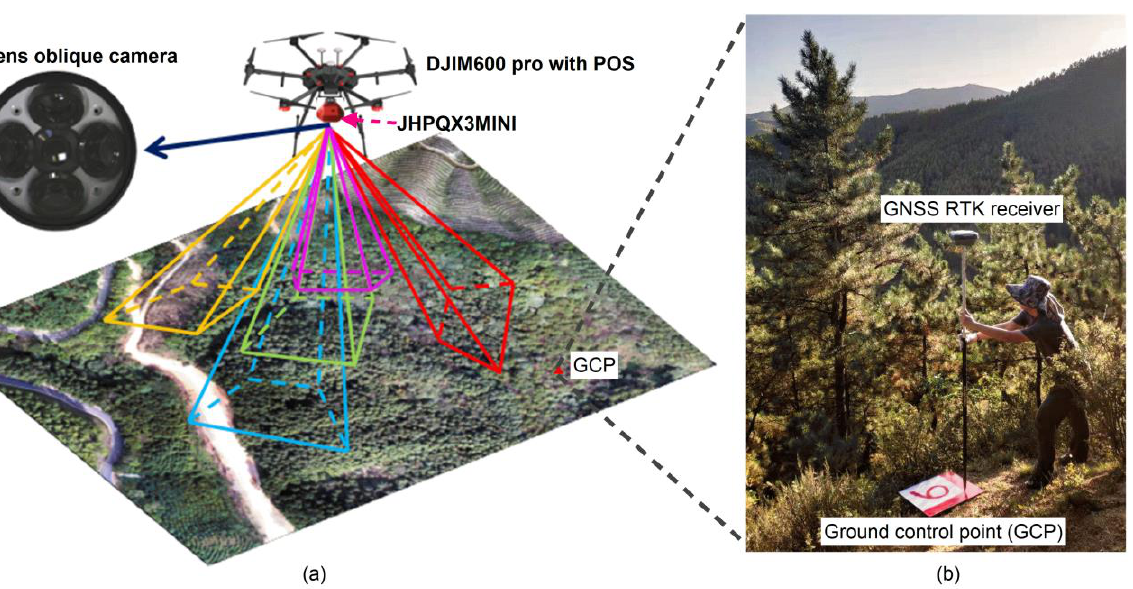
Figure 2. Schematic diagram of data collection for ( a ) UAV equipped with five-lens oblique camera and ( b ) GCP.